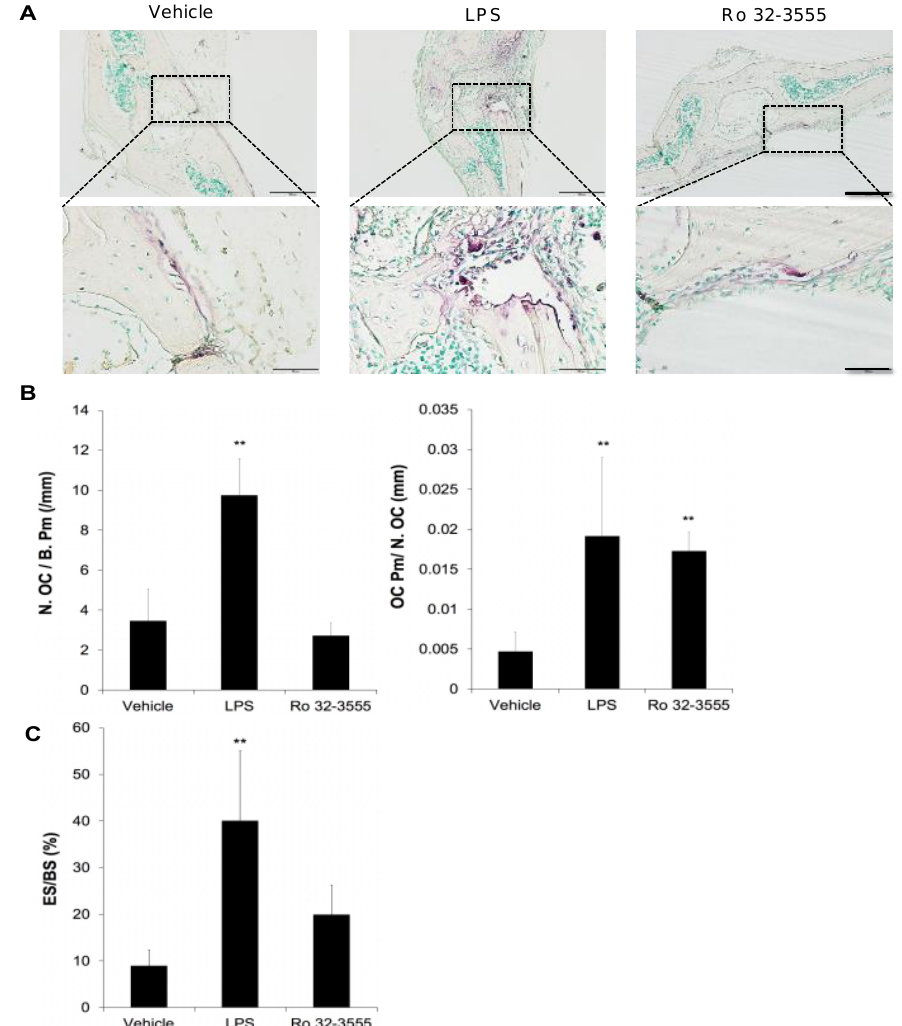
Figure 3. The effect of collagenase inhibition on osteoclastogenesis in calvarial bones. ( A ) Collagen sponges containing PBS, lipopolysaccharide (LPS), or Ro 32-3555 were surgically inserted onto mouse calvariae. At 5 days after stimulation, mice were sacrificed, and the calvarial bone sections were prepared and stained for TRAP-activities. Bone area on which collagen sponges were inserted was photographed. Scale bars indicate 200 mm and 50 mm in upper and lower panels, respectively. ( B ) Histomorphometry analyses were performed to examine osteoclast number (N. OC/B. Pm) and osteoclast size (OC Pm/N. OC). ( C ) Both osteoclast-positive and -negative resorption lacunae were measured to calculate eroded surface per bone surface (ES/BS). Data are mean ± SD obtained from 5 samples. **, p < 0.01 against vehicle-treated control.